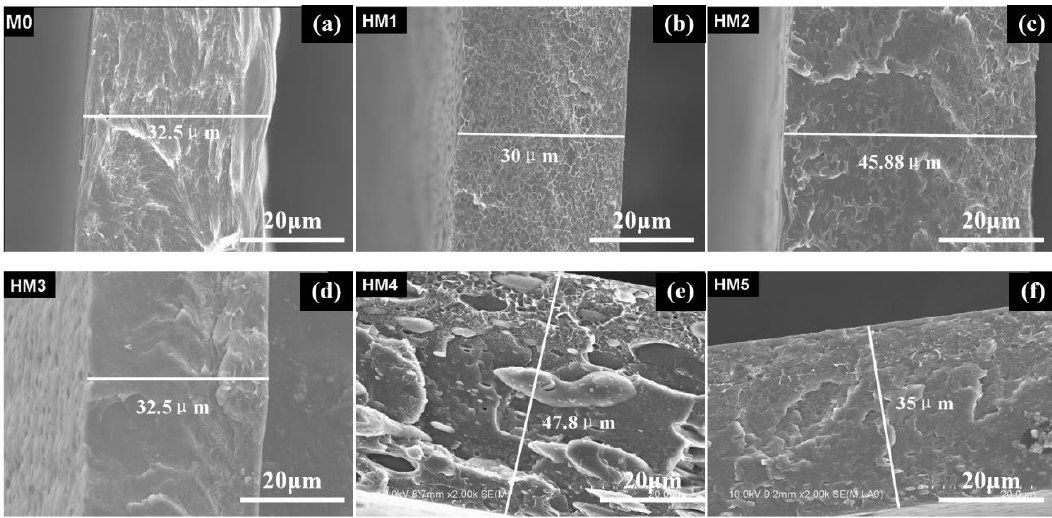
Figure 4. SEM images of the cross-sections of the blank membrane and organic–inorganic hybrid ion channel membranes: ( a ) M0; ( b ) HM1; ( c ) HM2; ( d ) HM3; ( e ) HM4; ( f ) HM5.